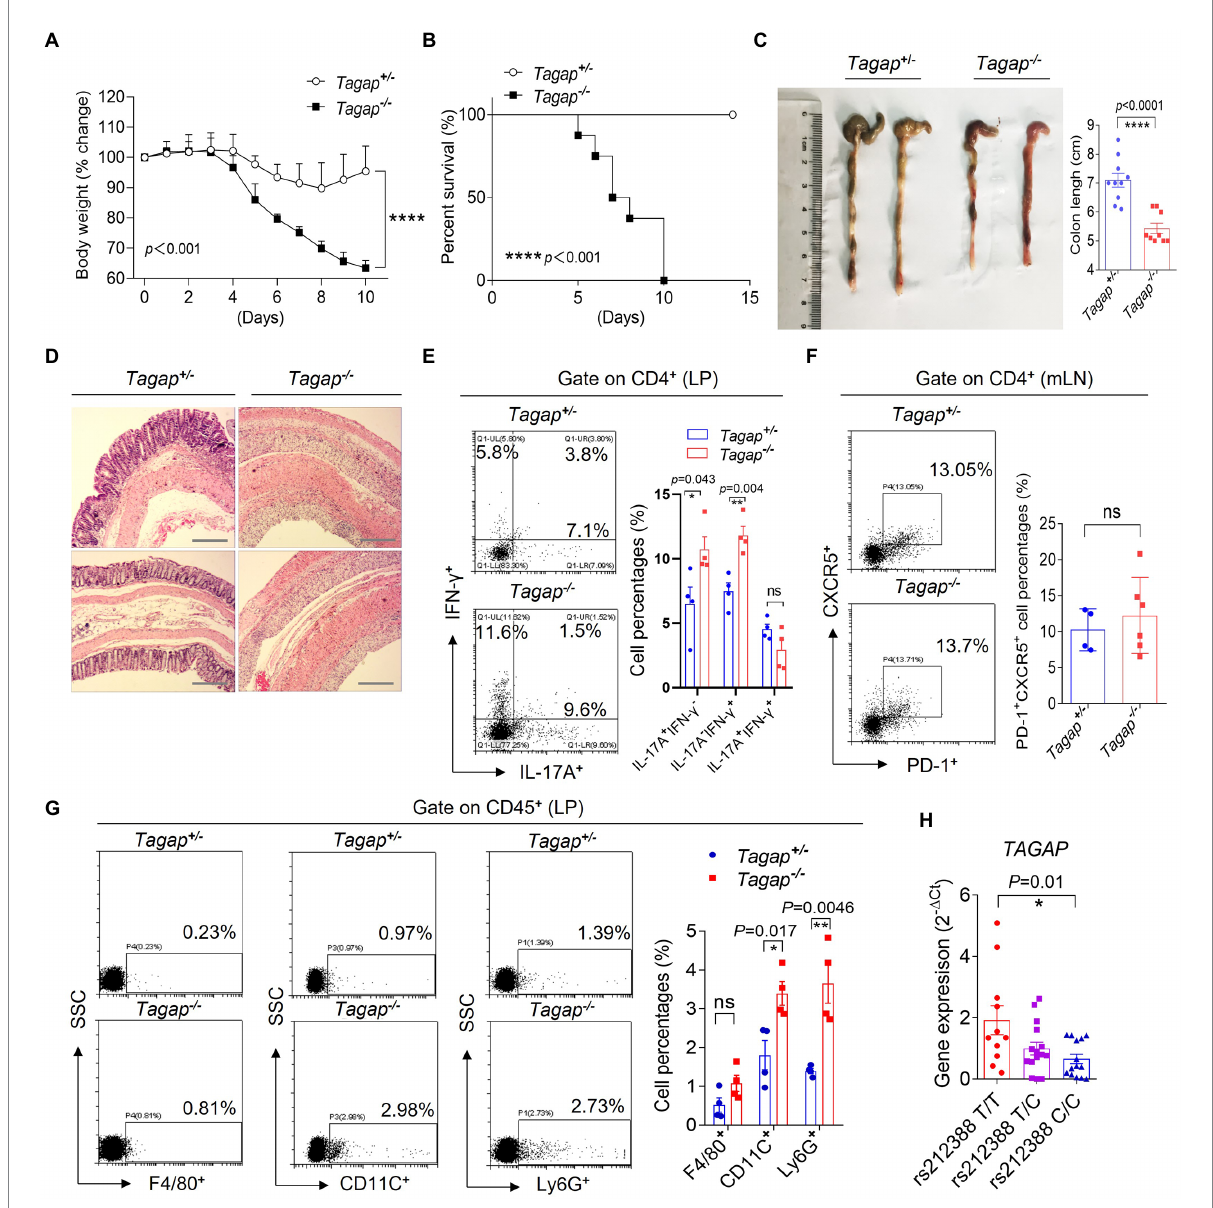
FIGURE 1 TAGAP-deficient mice were susceptible to DSS-induced colitis. (A) Littermate control mice or TAGAP-deficient mice were treated with 3% of DSS in the drinking water for 5 days, and then changed to normal water. Mice weight curve was shown, n = 7. (B) Littermate control mice or TAGAP- deficient mice were treated with 3% of DSS in the drinking water for 5 days, and then changed to normal water. Mice survival curve was shown, n = 9. (C) Representative colon picture of DSS-treated control mice and TAGAP-deficient mice was shown (left). Colon length of control mice and TAGAP-deficient mice after DSS treatment was shown (right), n = 9. (D) Hematoxylin staining of transversal sections of colon sample from DSS- treated control mice and TAGAP-deficient mice at day 7 was shown. Scale bar: 150 μ m. (E–G) Cells were isolated from lamina propria (E,G) or mesenteric lymph nodes (F) from littermate control mice or TAGAP-deficient mice after DSS treatment for 5 days, followed by flow cytometry analysis of indicated cells, n = 4. (H) TAGAP mRNA level was examined in the PBMCs of different individuals who carried the indicated TAGAP genotypes, n = 11, 15, and 14. The weight loss (A) and survival data (B) were from separate experiments. * p < 0.05, ** p < 0.01, *** p < 0.001, **** p < 0.0001 based on two-way ANOVA (A) , Two-sided unpaired T test ( C,E–H ) and Log-rank (Mantel-Cox) Test for panel ( B ). All error bars represent SEM of technical replicates. Data are representative of three independent